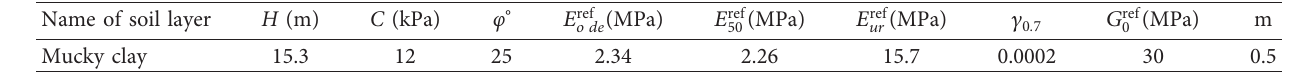
Figure 4: 3D numerical model. (a) 3D view. (b) Partially enlarged view of the tunnel and load position. Table 2: Parameters of the hardening constitutive model of mucky clay.